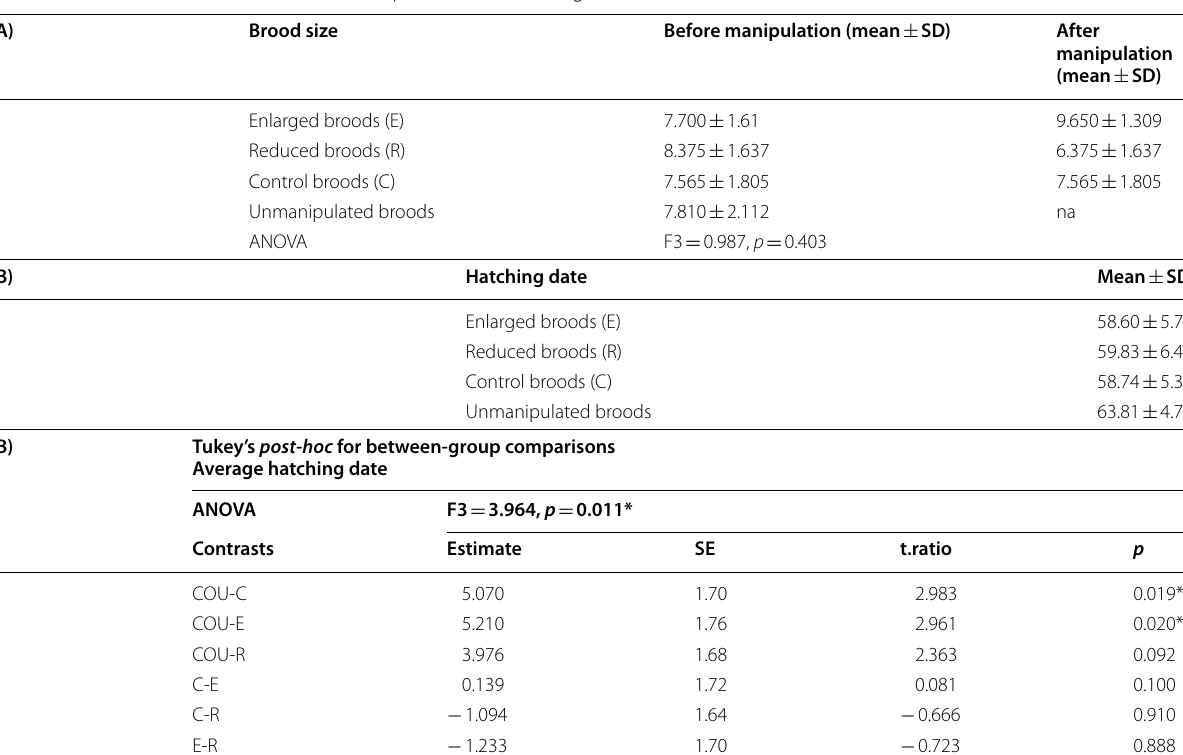
Table 1 (A) Brood size before and after manipulation, (B) hatching date across